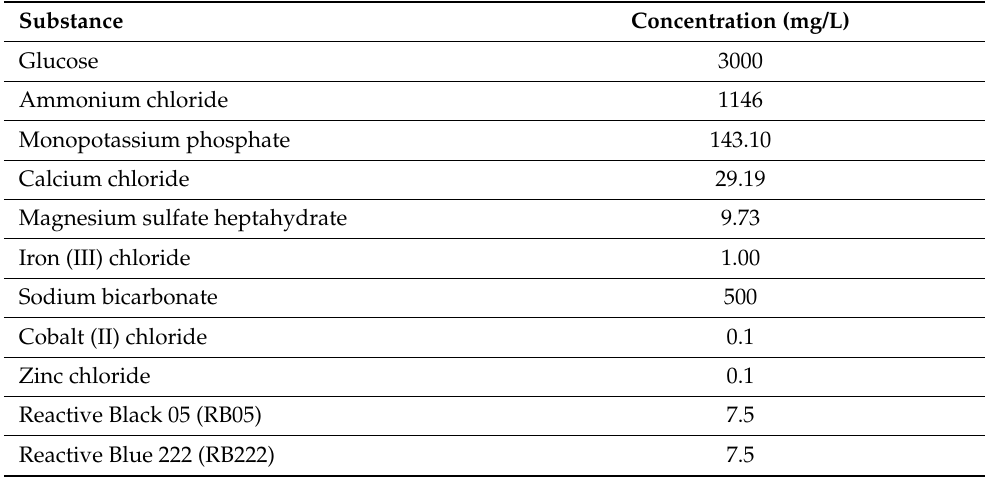
Table 1. Composition of synthetic textile wastewater used in eMBR experiments